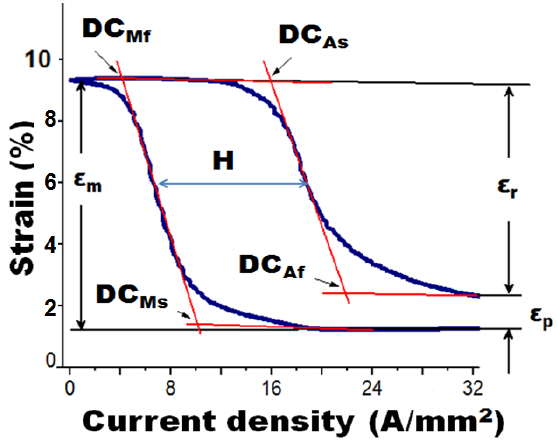
Figure 6. Martensitic transformation. ε r : SATWME or strain recovery; ε p : plastic deformation strain; DC Ms : start martensite transformation as a function of current density; DC Mf : finish martensite transformation as a function of current density; DC As : start austenite transformation as a function of current density; DC Af : finish austenite transformation as a function of current density; H: